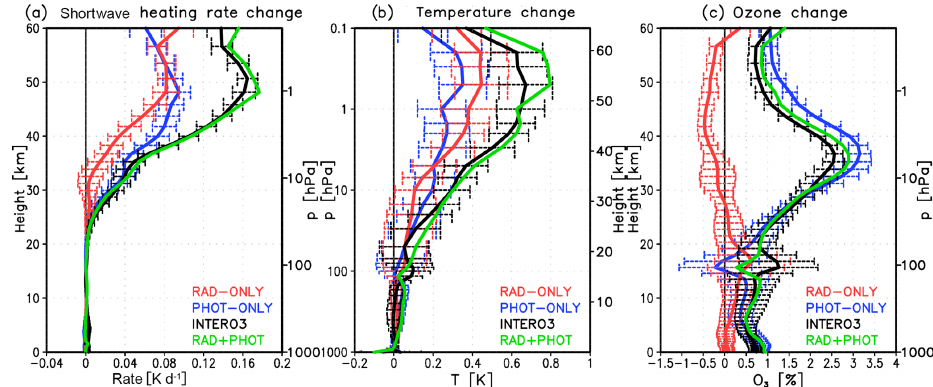
Figure 2. Yearly mean tropical average (25 ◦ N–25 ◦ S) change in (a) the shortwave heating rates (Kd − 1 ), (b) temperature (K), and (c) ozone (%) between SMAX and SMIN for RAD-ONLY (red), PHOT-ONLY (blue) and INTERO3 (black), together with the associated confidence intervals ( ± 2 standard errors). The green line indicates the sum of the RAD-ONLY and PHOT-ONLY